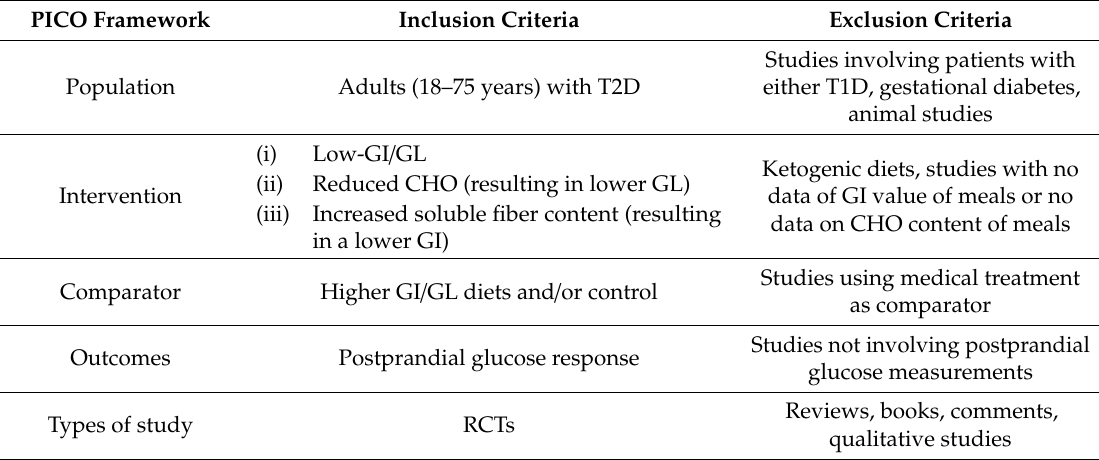
Table 1. Selectioncriteriabasedonpopulation, intervention, comparator, andoutcomes(PICO)framework. PICO Framework Inclusion